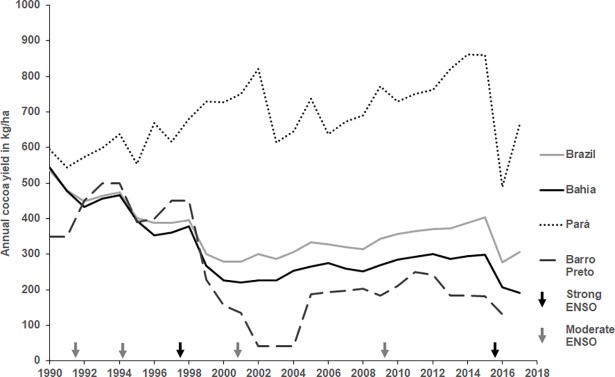
Cocoa production in Brazil, Bahia, Para and Barro Preto since 1990.The continuous grey line represents Brazilian cocoa production; the continuous black line represents the cocoa production for the state of Bahia and the dotted black line the state of Para. The discontinuous black line represents the cocoa production for the municipality of Barro Preto (source: IBGE). Black arrows represent strong ENSO events (1997–1998, 2015–2016), grey arrows represent moderate ENSO events (1991–1992, 1994–1995, 2002–2003, 2009–2010). The Moniliophthora perniciosa outbreak started in Bahia in 1989.